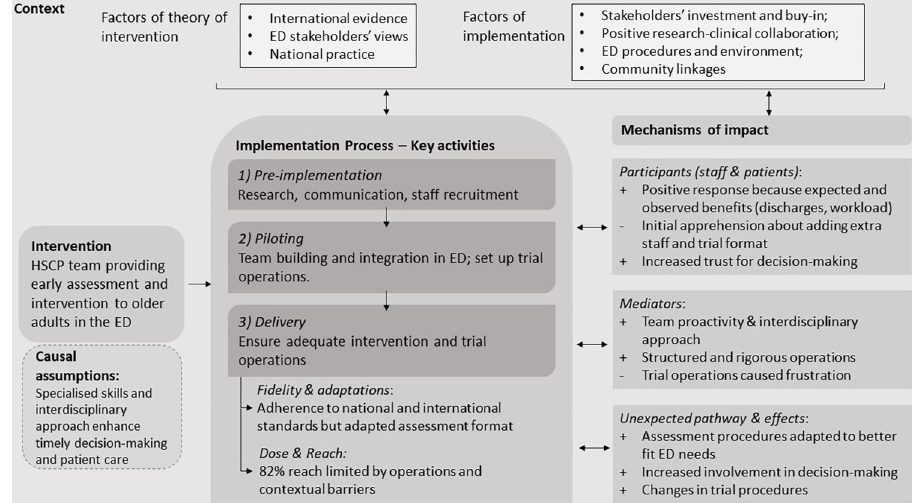
Fig 1. Implementation framework of a HSCP team intervention for older adults in the ED [27]. (+) indicates an enabler, (-) refers to a barrier.